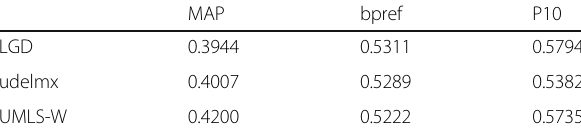
Table 2 The comparison of Baseline, UMLS-E, and UMLS-W